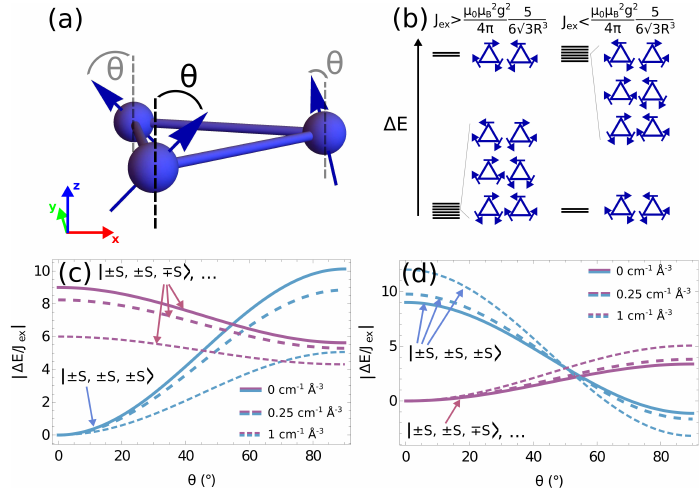
Figure 1. ( a ) Schematic depiction of the molecular triangle with on-site magnetic anisotropy axes (blue arrows) arranged tangentially about the vertices of the triangle and canted by an angle θ from ˆz . ( b ) Ground and first excited exchange multiplets of the semi-classical Ising states of the triangle with idealised in-plane magnetic anisotropy θ = 90 ◦ . ( c , d ) Energy as a function of canting angle θ of the lowest lying Ising exchange manifolds in the semi-classical on-site spin S = 3/2 molecular triangle for ratios of | J ex | / R 3 = 0 cm − 1 Å − 1 (solid), 0.25 cm − 1 Å − 1 (dashed) and 1 cm − 1 Å − 1 (fine dashed) for ( c ) ferromagnetic and ( d ) antiferromagnetic exchange coupling J ex